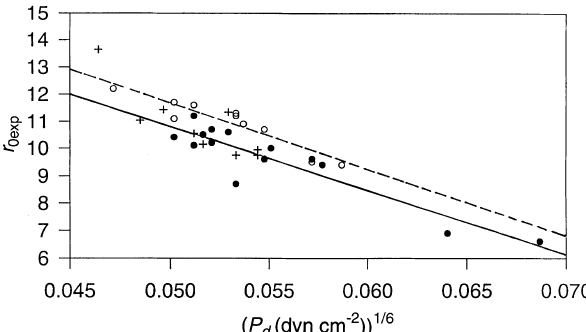
Fig. 2. Scatter plot of observed magnetopause stand-o(cid:128) distances versus ( P d ) 1 = 6 for crossings with northward ( open circles ), intermediate ( crosses ), and southward ( filled circles ) IMF. Dashed and solid lines represent linear regression lines for crossings with northward and southward IMF